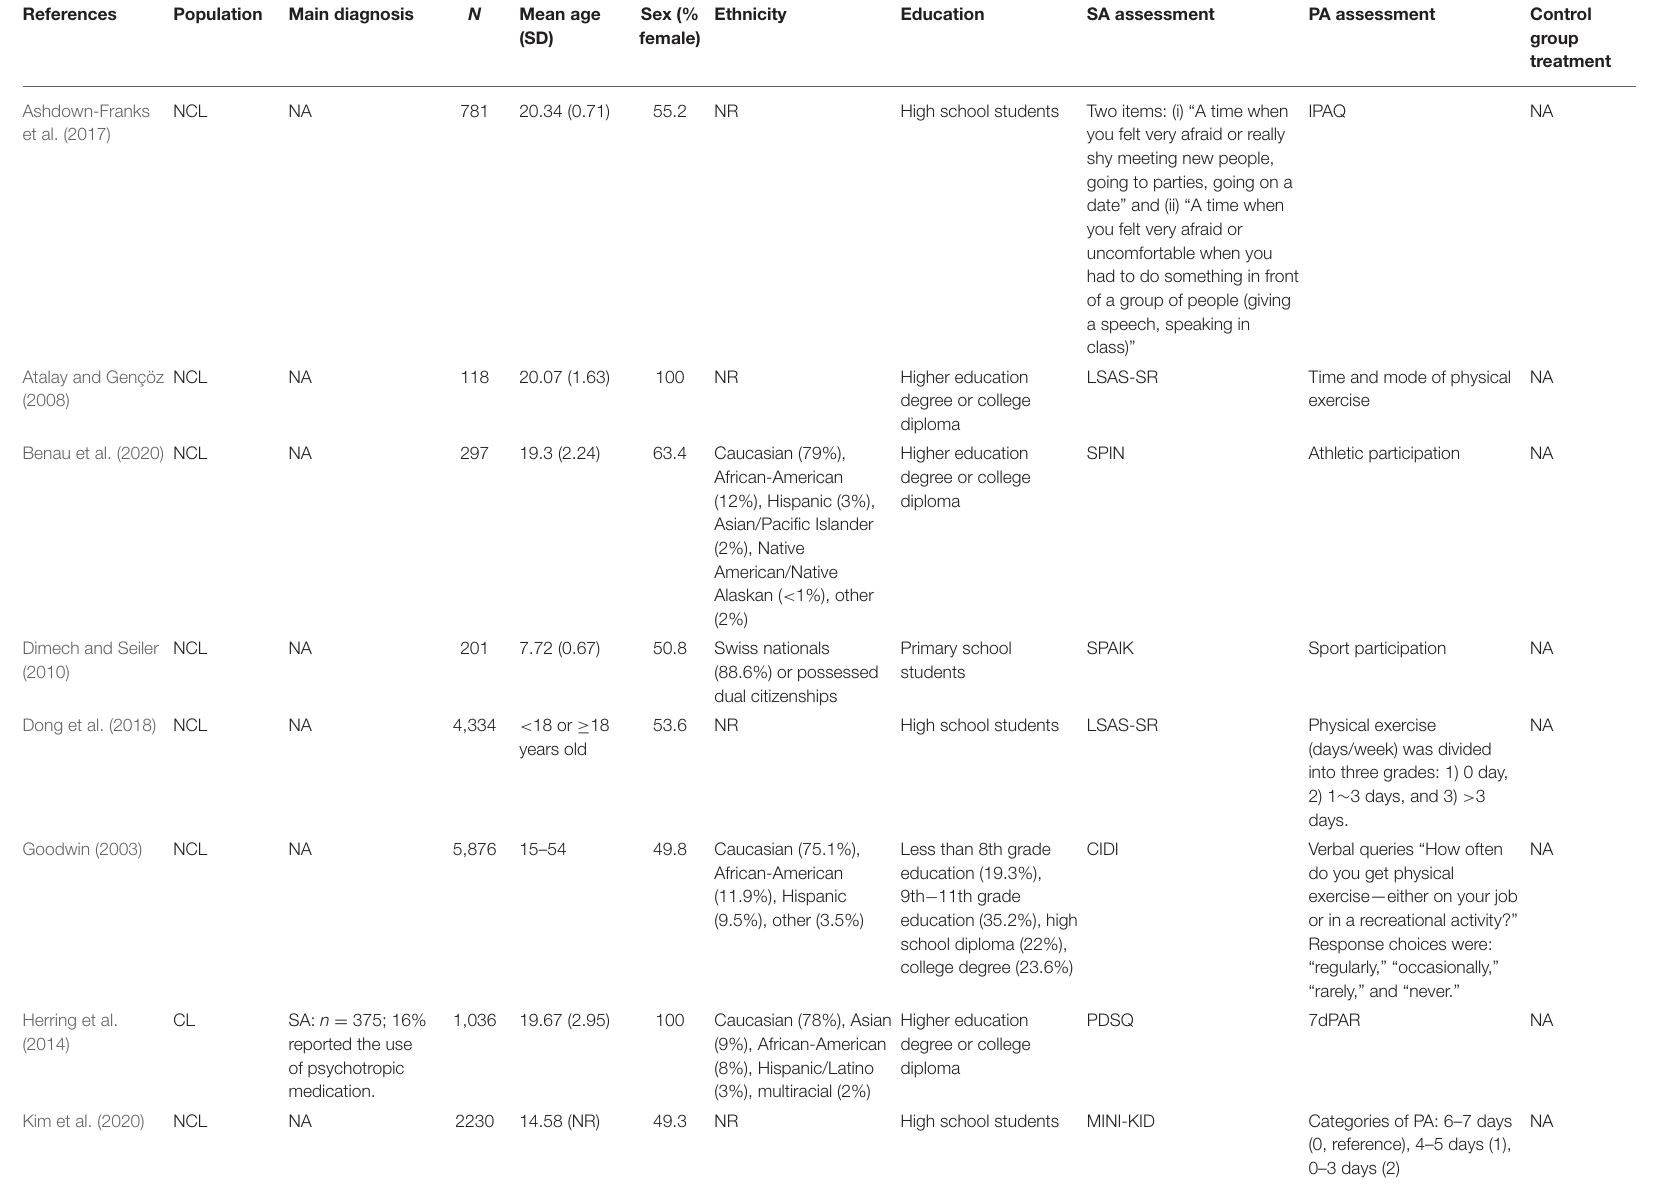
TABLE 3 | Characteristics of the cross-sectional studies that were included in the